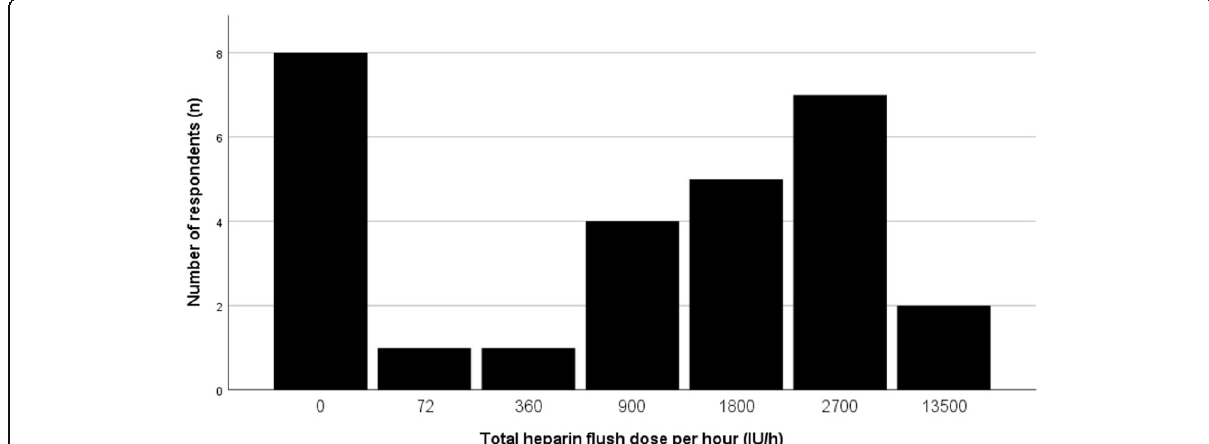
Fig. 1 Calculated dose of total heparin entering the patient through flush fluids per hour (IU/h). The dose ranges from 0 IU/h (8 respondents) to 13.500 IU/h (2